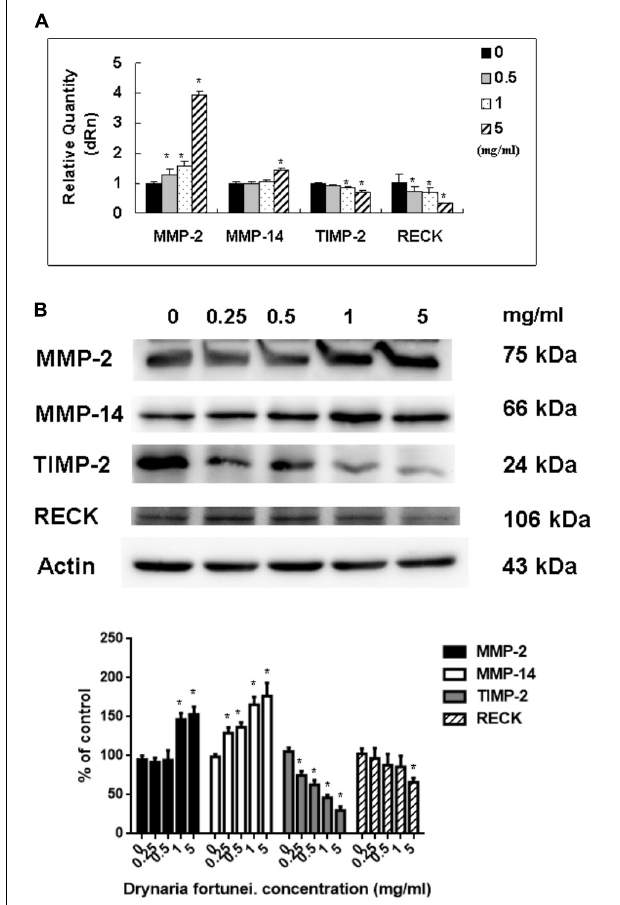
FIGURE 6 | The measurement of mRNAs and proteins, including MMP-2, MMP-14, TIMP-2, and RECK by D. fortunei. (A) The relative quantity of mRNA, including MMP-2, MMP-14, TIMP-2, and RECK with different concentrations of D. fortunei as indicated. The mRNA levels of MMP-2 and MMP-14 were upregulated, while TIMP-2 and RECK were downregulated significantly by D. fortunei . HUVECs treated with or without D. fortunei for 24 h were processed for Western blot method to analyze the protein levels of MMP-2 and TIMP-2 in conditioned media without concentration as well as MMP-2, MMP-14, TIMP-2, and RECK in cytosol. (B) The protein levels of MMP-2 and MMP-14 in cytosol were increased. Conversely, the protein levels of TIMP-2 and RECK in cytosol were decreased. Data were mean ± SD calculated from three individual experiments. An asterisk demonstrated the significant difference ( ∗ P < 0.05) compared with